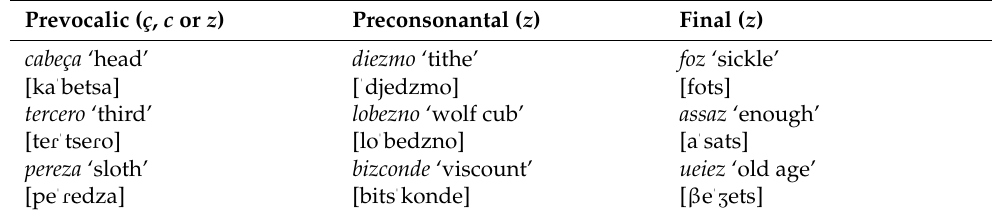
Table 2. Distribution of the letters ç, c e , i and z in Old Spanish and their phonetic correlates. Prevocalic ( ç , c or z